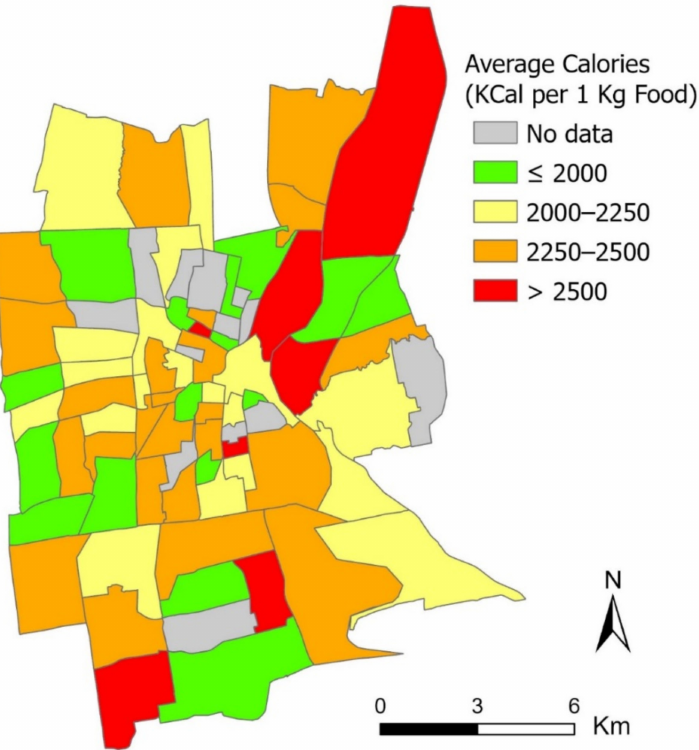
Figure 5. The RN index in terms of average calories of restaurant food by census